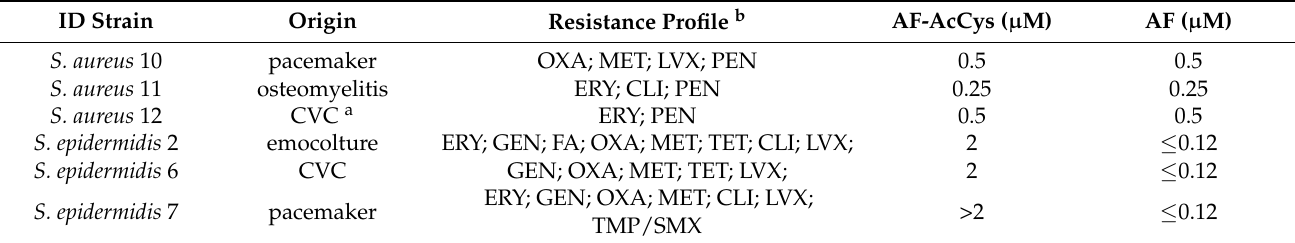
Table 1. MIC ( µ M) values of AF-AcCys and